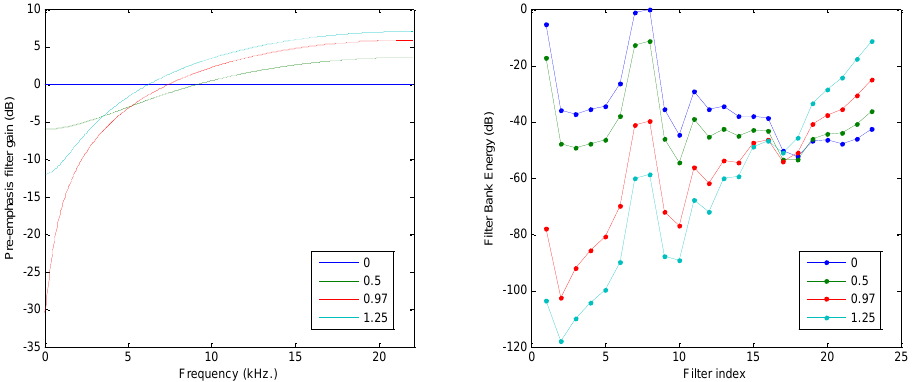
Figure 15. Pre-emphasis filter: ( left ) filter spectral response; ( right ) effect on FBE.